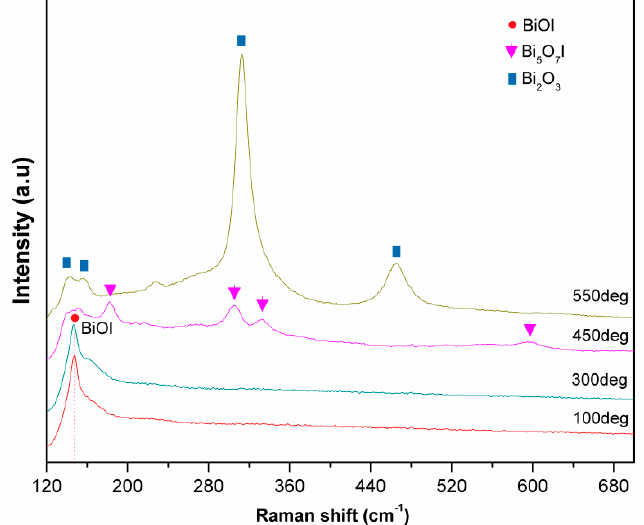
Figure 2. Raman spectra of annealed BiOI at different temperatures: 100 °C, 300 °C, 450 °C, and 550 °C.